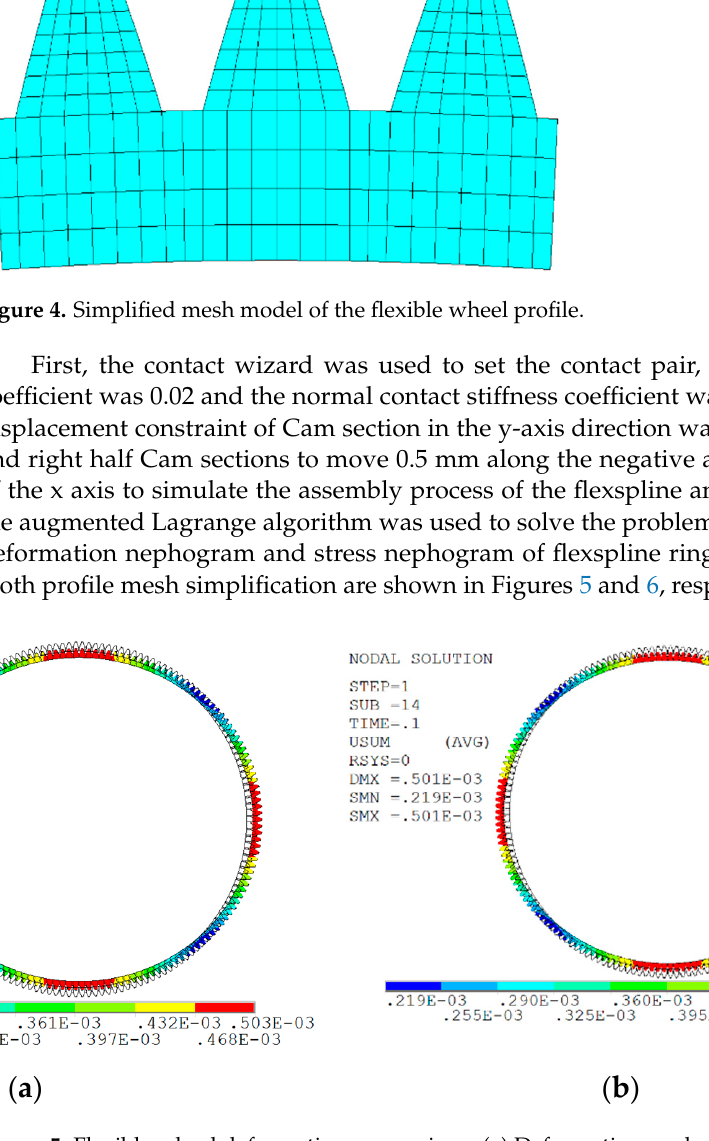
Figure 3. Mesh model of the flexible wheel profile.